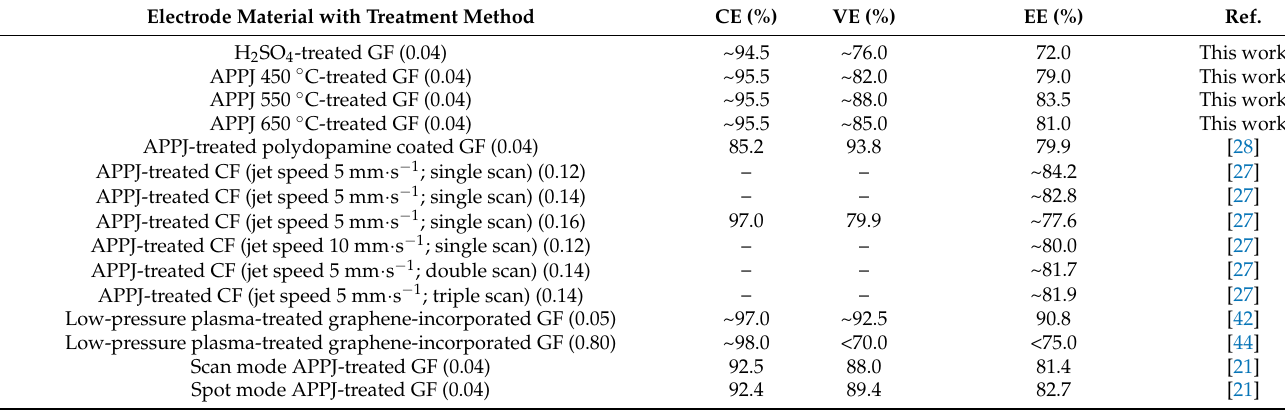
Table 2. A comparison of some plasma-treated carbonaceous electrodes with the present work. The quantity in bracket in the first column indicates the values of constant current density, in A · cm − 2 , during the charge/discharge process. Electrode Material with Treatment Method CE (%) VE (%) EE (%) Ref. H 2 SO 4 -treated GF (0.04) ~94.5